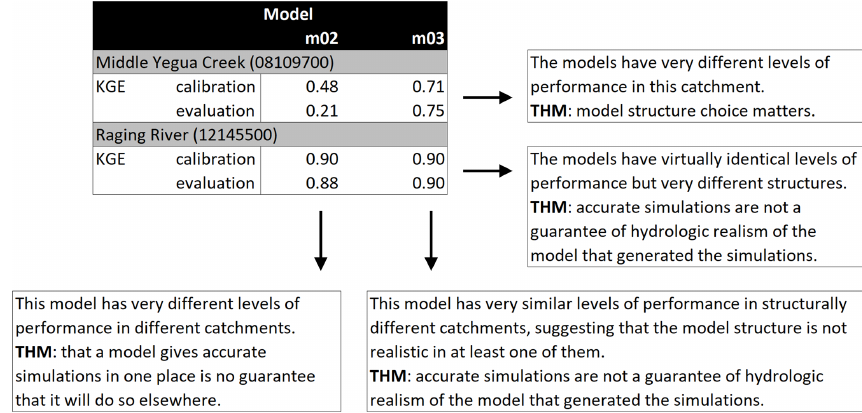
Figure 1. Shown are the calibration and evaluation Kling–Gupta efficiency (KGE) scores that students will find when calibrating a single optimal parameter set for each combination of model and catchment, using their own adaptation of existing calibration code included in the MARRMoT repository. The calibration period is set as 1 January 1989 to 31 December 1998; evaluation data cover the period 1 January 1999 to 31 December 2009. Comparative assessments of these KGE scores transfer certain take-home messages (THM) about hydrological model structure uncertainty, as detailed in the four text